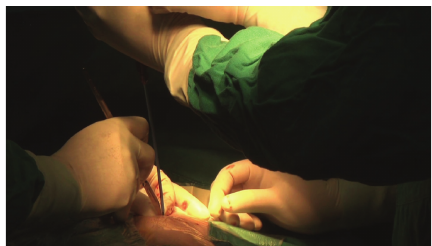
Figure 1: In the 4th intercostal space of the left sternal border, puncture directly through the right ventricular surface into the right ventricle with an 18G needle, and then pass the guide wire into the left ventricle through the sheath.